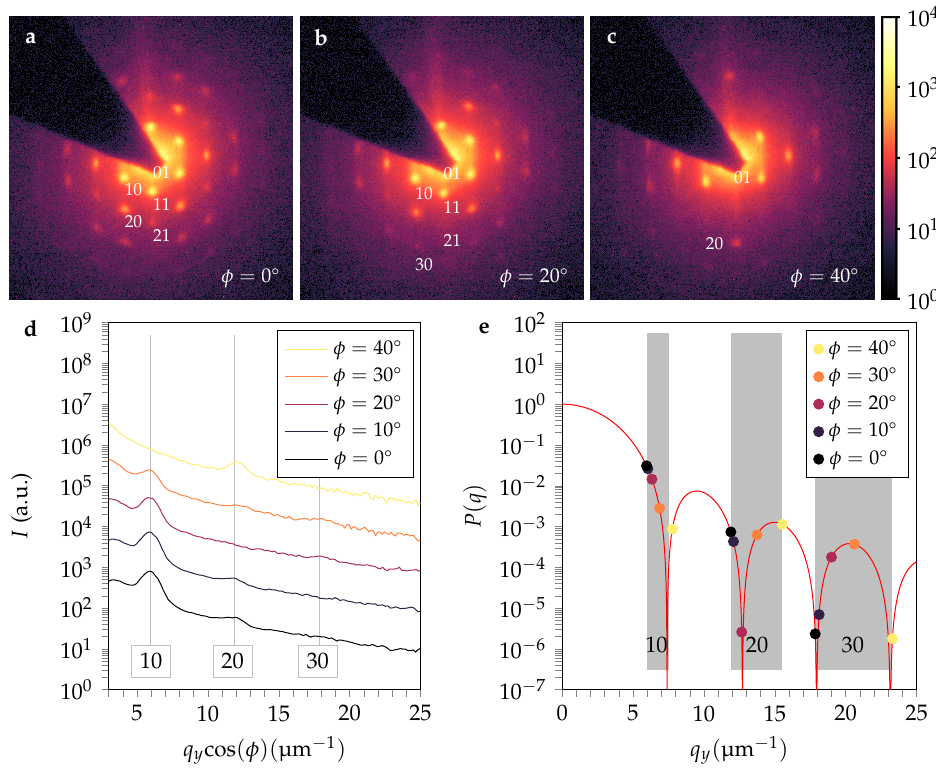
Figure 3. ( a – c ) 2D SAXS patterns of a monolayer prepared from colloidal silica spheres with an average diameter of D = 1.10µm ± 3.2% imaged at rotations around the x -axis of φ . The Bragg peaks are labelled on their left. ( d ) Cross sections of the diffraction patterns at different φ taken at q x = 0µm − 1 versus q y cos ( φ ) , revealing that the positions of the identified hk peaks occur at specific q y cos ( φ ) positions. ( e ) Positions of the 10, 20 and 30 peaks for different φ overlayed on top of the calculated spherical form factor P ( q )